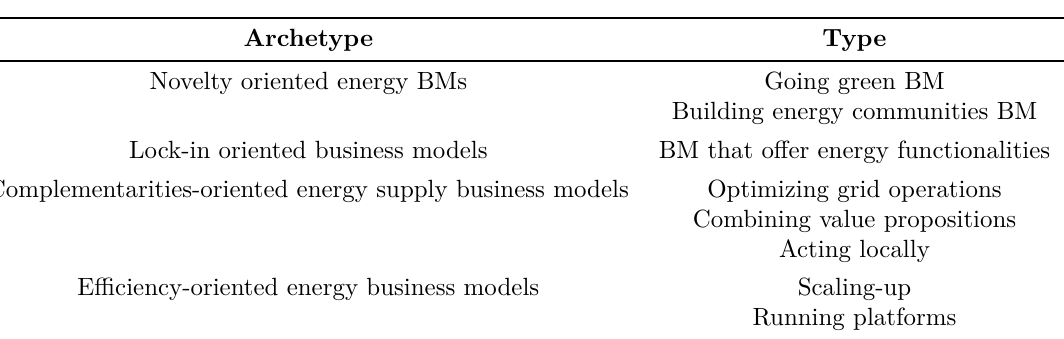
Table 1. Summary of business